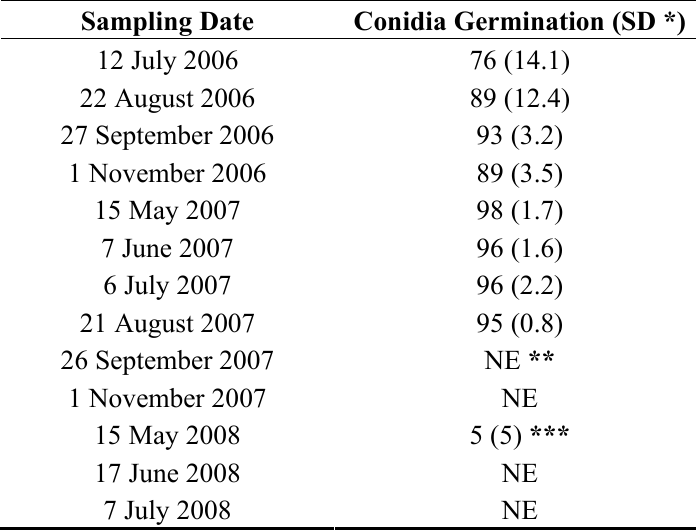
Table 1. Sampling dates of branches with mean germination percentage of 400 conidia observed for each sample date from 2006 to